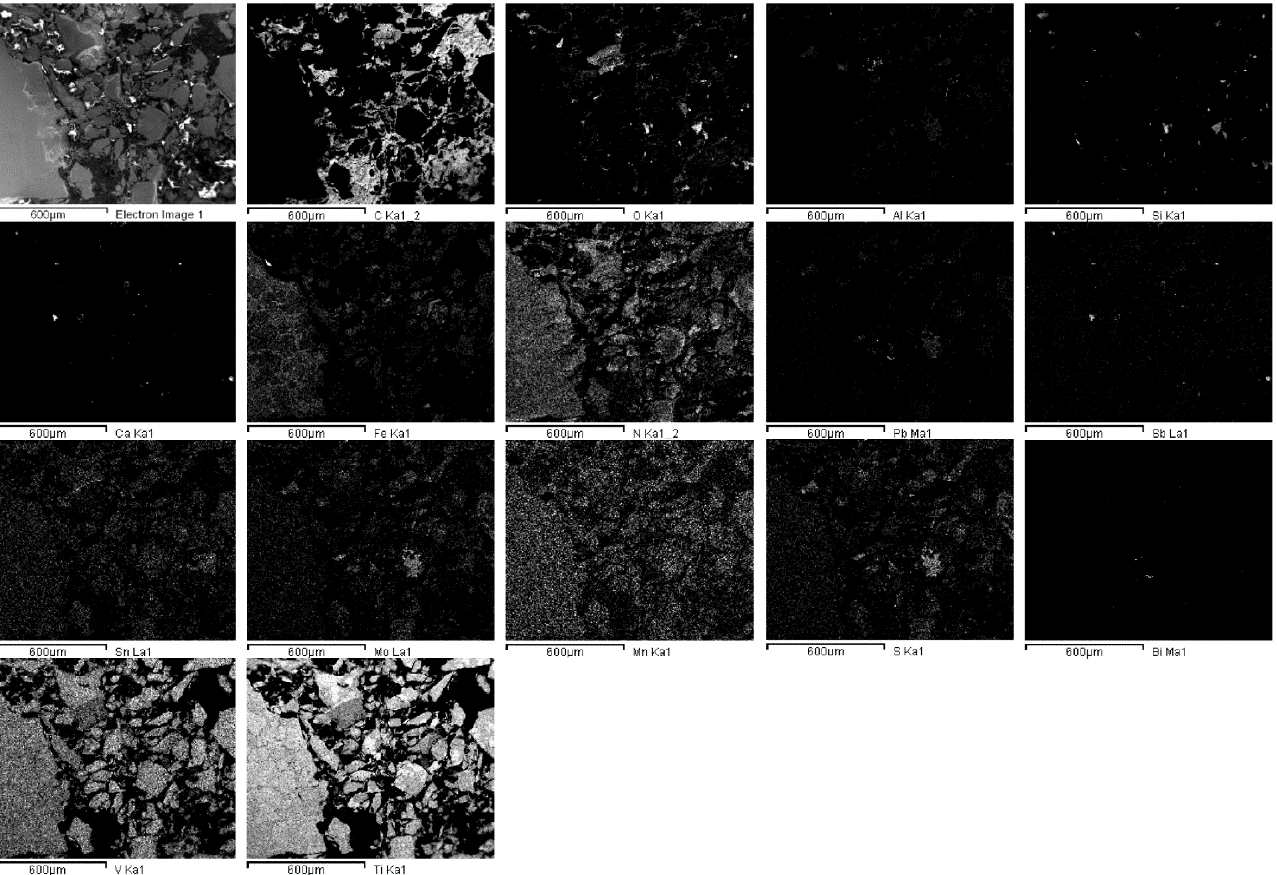
Figure 2. SEM image and the corresponding X-ray elemental mappings showing the distribution of elements in the FeTi-cored wire (C, O, Al, Si, Ca, Fe, N, Pb, Sb, Sn, Mo, Mn, S, Bi, V, Ti).